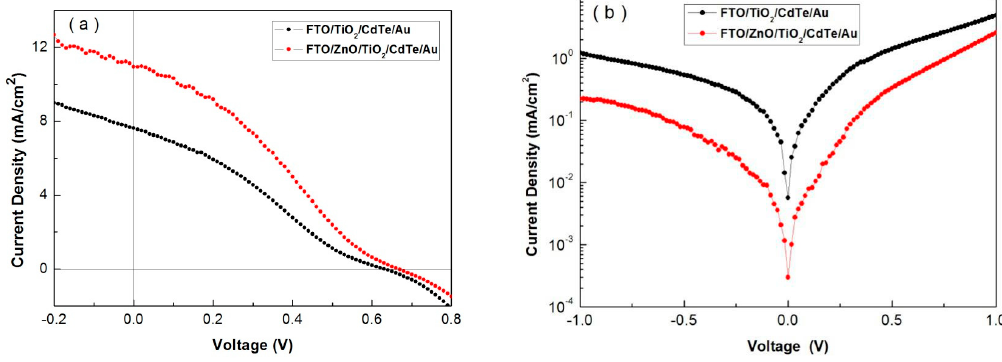
Table 1. Summarized performances of CdTe-TiO 2 heterojunction solar cells w/o ZnO film